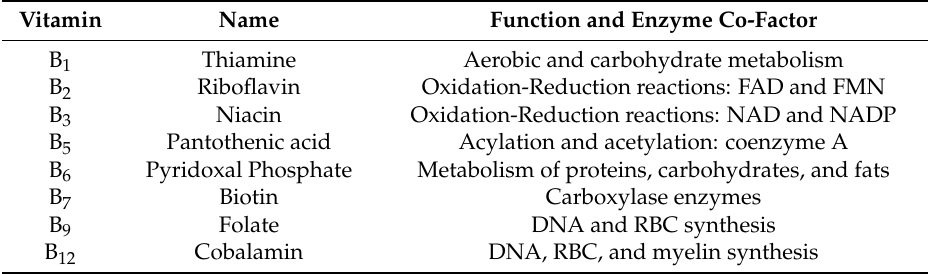
Table 1. Vitamin B complex and functions.